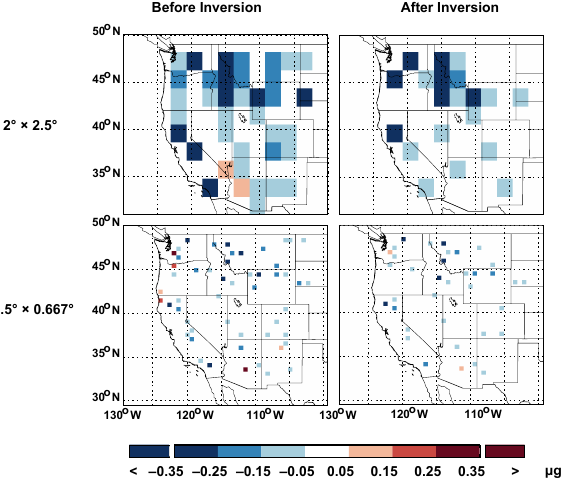
Figure 10. Differences between GEOS-Chem simulated and ob- served 24-hour average surface BC concentrations at the 69 IM- PROVE sites (Fig. 1) for August 2006. Model results are from the adjoint inversions at 2 ◦ × 2.5 ◦ (Case 1, Table 1) and 0.5 ◦ × 0.667 ◦ (Case 9, same as Case 1, except at 0.5 ◦ × 0.667 ◦ ) with the a priori or a posteriori